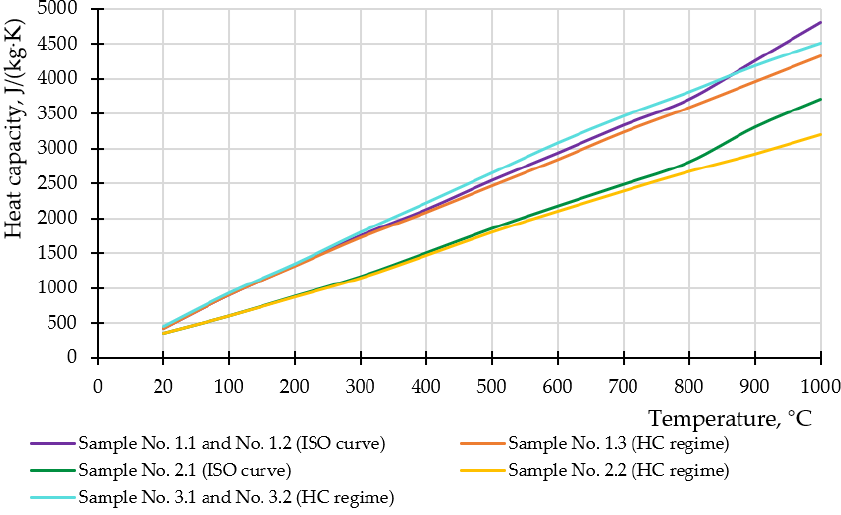
Figure 16 . Calculated coefficients of heat capacity of plaster compositions as a function of tempera-